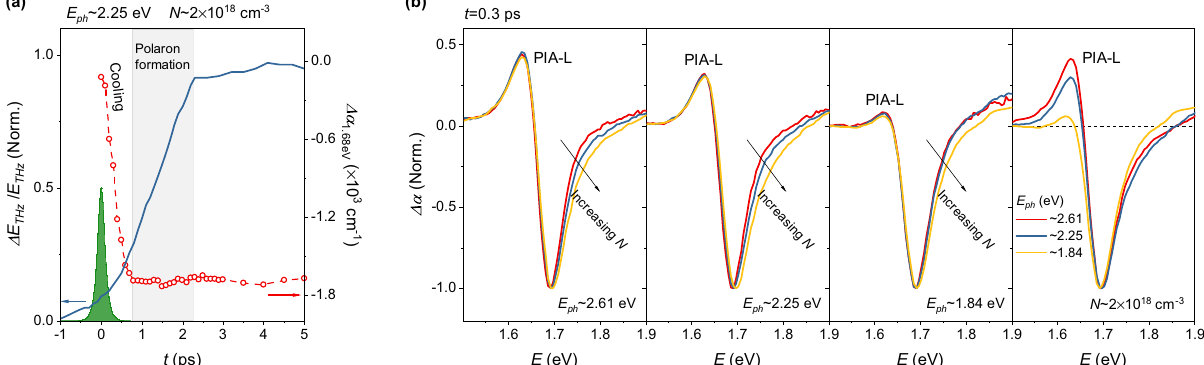
Fig. 2 The TA spectra of CsFAMA thin fi lms at early times after photoexcitation. a Left axis: normalized terahertz kinetics (blue solid line). Right axis: time evolution of the TA bleach (peaked at ~1.68 eV) after photoexcitation (red dashed line). The green area represents the correlation (width ~176 fs) of pump and probe laser pulses. The TA bleach reaches its maximum in ~1 ps due to hot-carrier cooling, while the terahertz signal reaches its maximum at ~2 ps. The rise of the terahertz kinetics observed after hot-carrier cooling is an evidence of polaron formation (shaded area). b Normalized TA spectra at 0.3 ps delay for different carrier densities and photon energies. PIA-L represents the photo-induced absorption at low probe photon energies, which scales with the carrier density, but decreases with decreasing pump photon